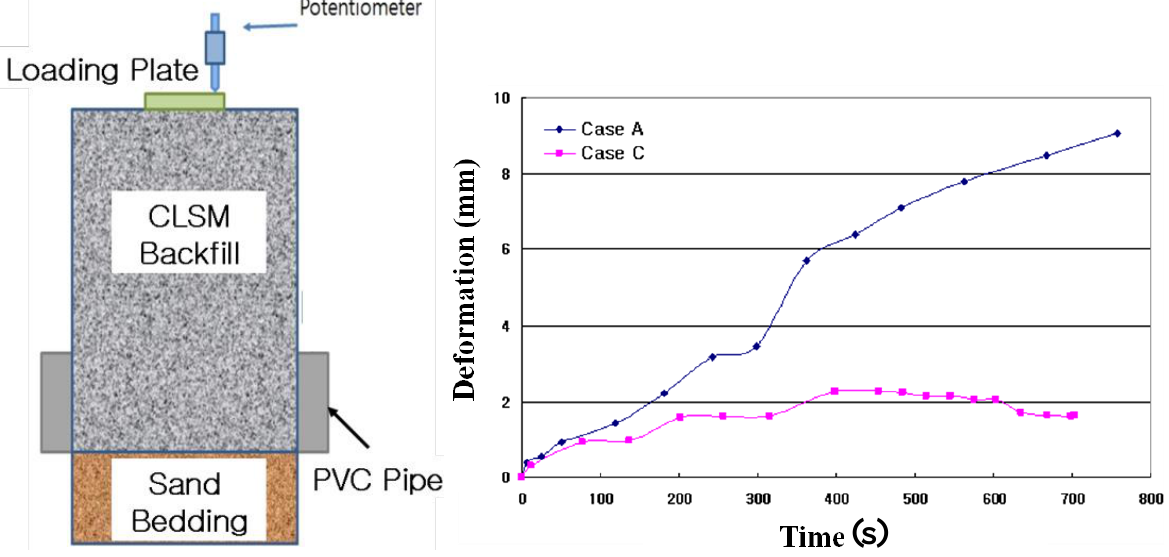
Figure 12. Deformation (mm) at Surface of CLSM